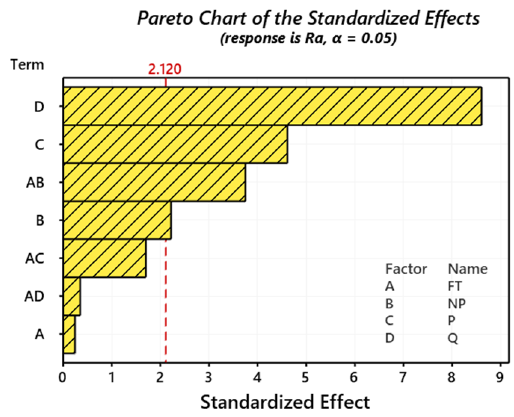
Figure 4. Pareto chart of effects of input machining factors on surface roughness R a . (A is FT : Fluid type, B is NP : nanoparticle, C is P : air pressure, D is Q : air flow rate).